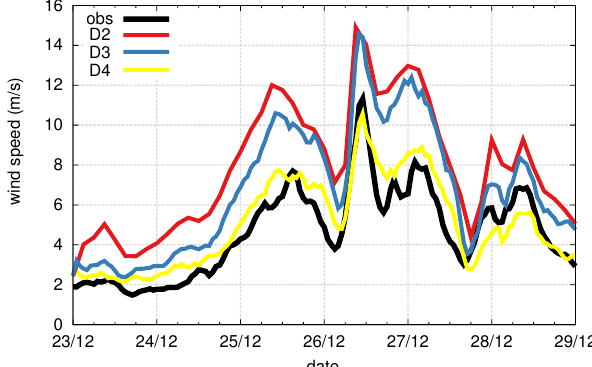
Figure 10. Site-averaged series of wind speed in the 6-day case study containing storm Lothar. Black and yellow lines correspond to the observations and simulation in domain D4 corresponding to C6 in Table 2 (same series as in Fig. 4). The red and blue lines correspond to the result with the same model configuration, but in domains D2 and D3,